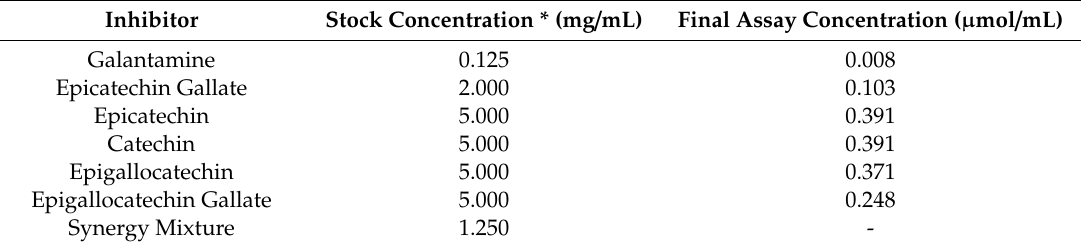
Table 2. Test stock concentrations: inhibitors were first tested at the highest concentration available to determine if any inhibition was present before further analysis was carried out. Inhibitor Stock Concentration * (mg / mL) Final Assay Concentration ( µ mol / mL) Galantamine 0.125 0.008 Epicatechin Gallate 2.000 0.103 Epicatechin 5.000 0.391 Catechin 5.000 0.391 Epigallocatechin 5.000 0.371 Epigallocatechin Gallate 5.000 0.248 Synergy Mixture 1.250